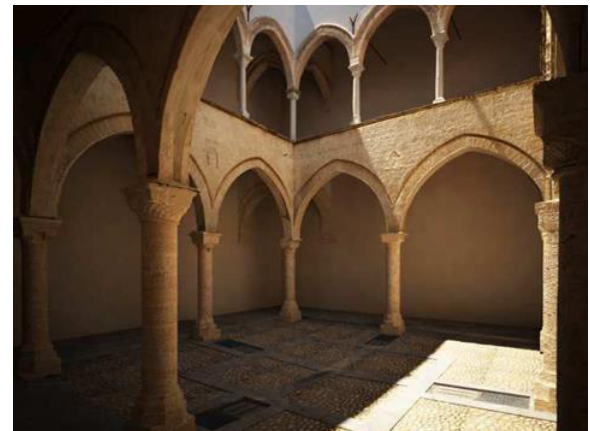
Figure 14. 3D photorealistic model –ground floor